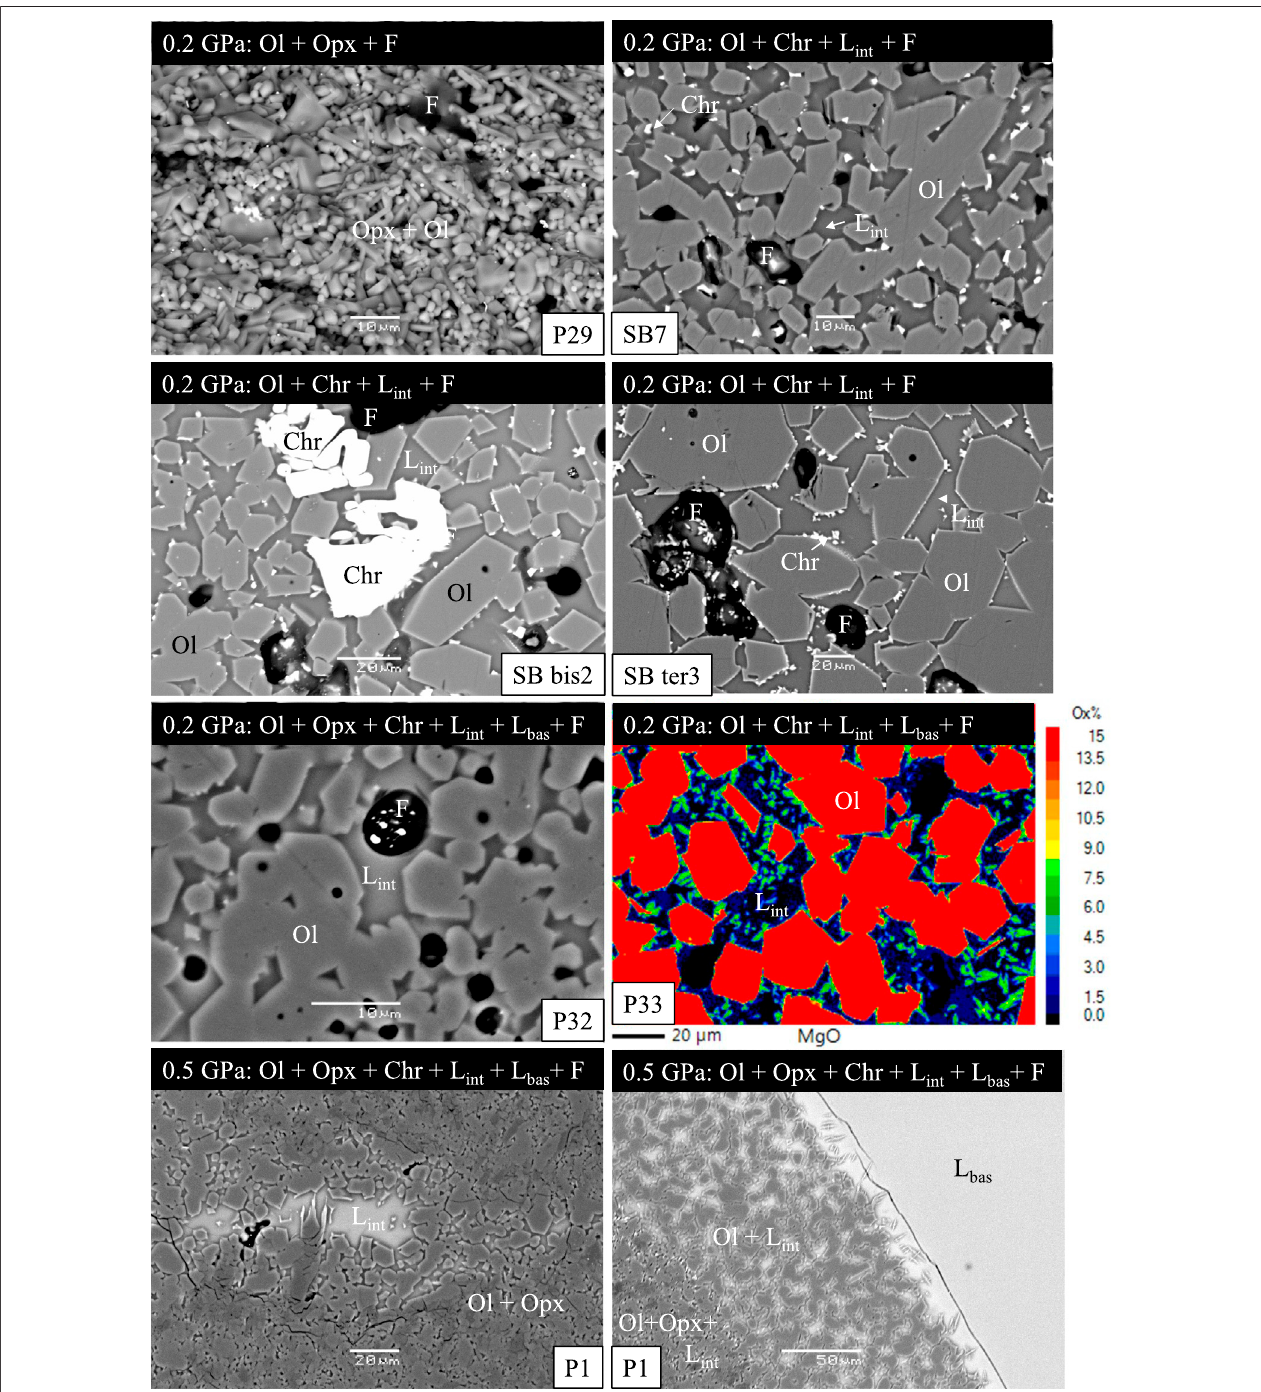
FIGURE2| BackscatteredelectronimagesandelementalX-raymapsofthehybridandmixedrunstoinvestigateaqueous fl uid-assistedpartialmeltingofperidotite at pressures of 0.2 and 0.5 GPa. The images show mineral, glass and fl uid phase associations observed in the capsules, particularly the olivine-rich zones after quenching. Ol, Opx, Chr, L int , L bas , and F on the images stand for olivine, orthopyroxene, chromite, interstitial and basaltic glass, and fl uid bubbles, respectively. The run numberscorrespondtothoseusedin Table1 ; SupplementaryTableS2 .(P29)Theserpentinitedehydrationsampleproducedat0.2 GPadisplaysasinglezone representedbyenstatitewithhigh-Mgolivineandorthopyroxene.(SB7,SBbis2,andSBter3)Themixedsampleswithhighestinitialproportionsofserpentinite(80 wt%; R (cid:1) 0.25) are characterized by a unique polyhedral olivine-rich domain of unzoned crystals of olivine associated with interstitial felsic glass (L int ) and fl uid bubbles. Chromiteisassociatedwiththeeuhedralolivinegrains(high-MgolivineFo 90 – 94 ).(P32)ThehybridrunsampleP32lasting2.5 hat1,250 ° Cand0.2 GPa( R (cid:1) 4.6)showsa former-serpentinite zone with an inner harzburgite part and an outer olivine-rich part (olivine Fo 89 ± 1 ) composed of olivine and interstitial glass. Chromite is localized